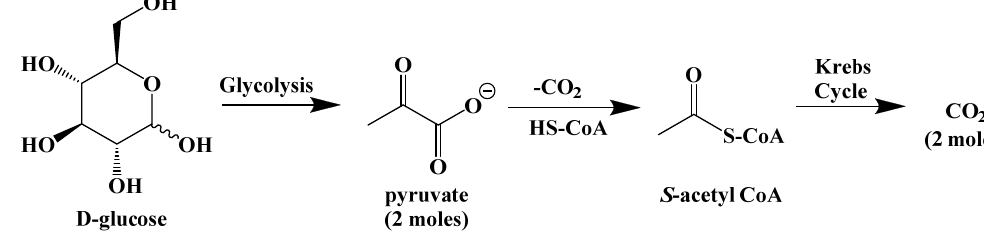
Figure 8. Metabolism of Glucose.